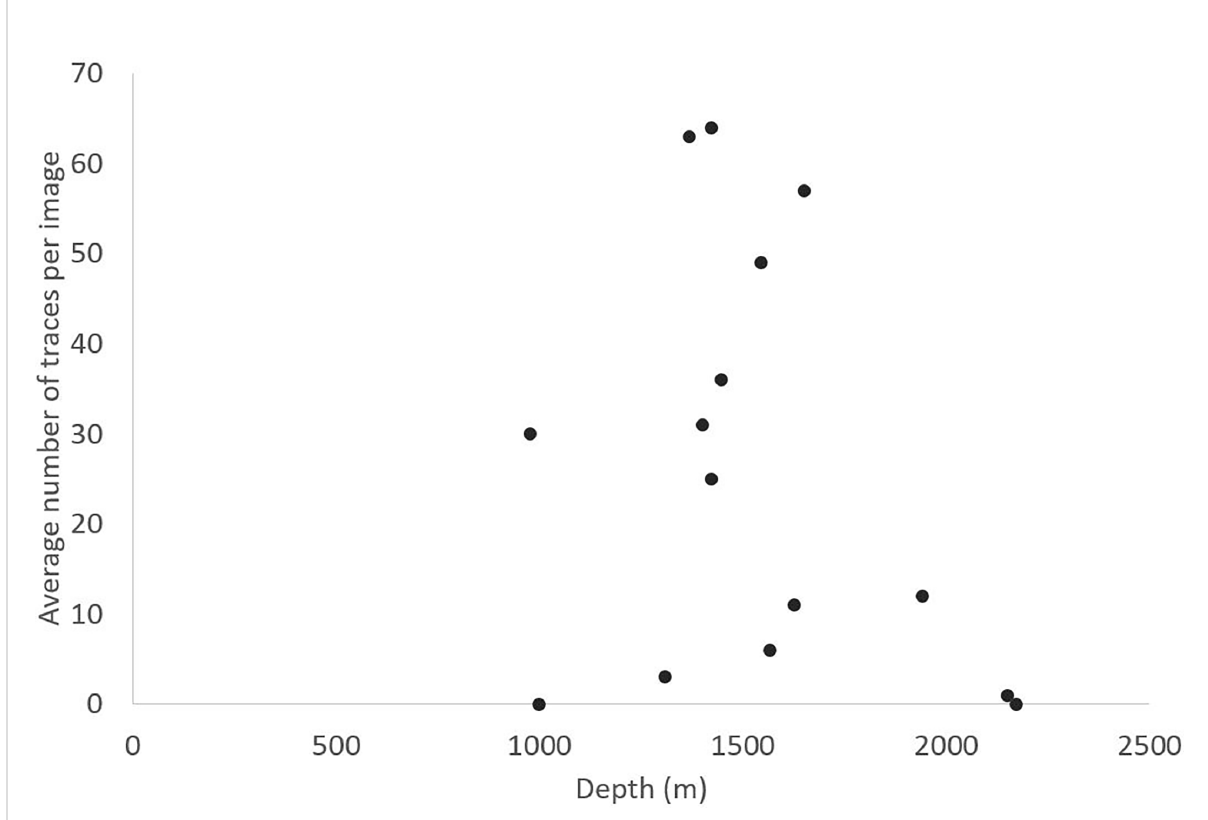
FIGURE 3 The relationship between depth and spider traces from the Eastern margin. Each dot represents a towed video transect, and only those transects from which >50 still images were acquired were included. Two transects had no spider traces